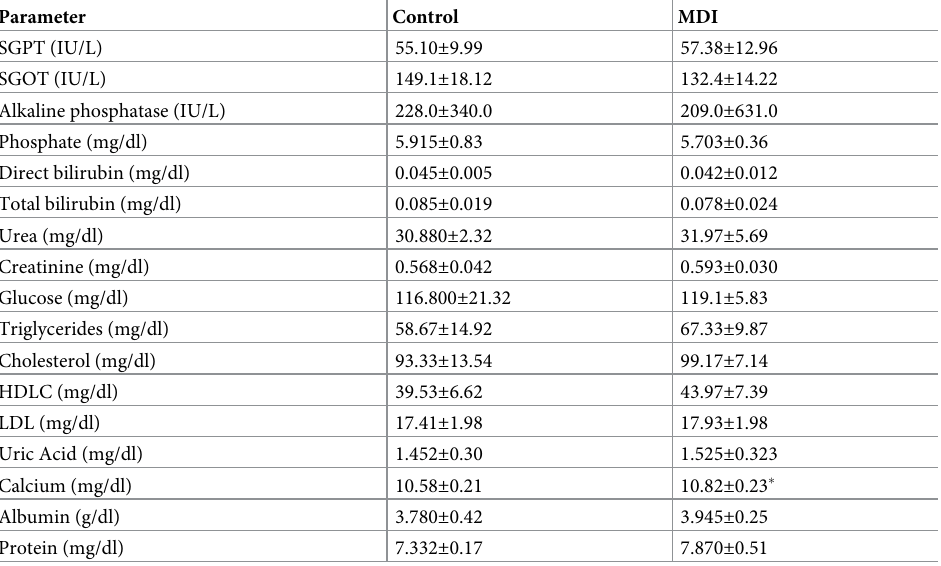
Table 3. Effect of MDI on serum biochemical parameters of female rats in acute toxicity.